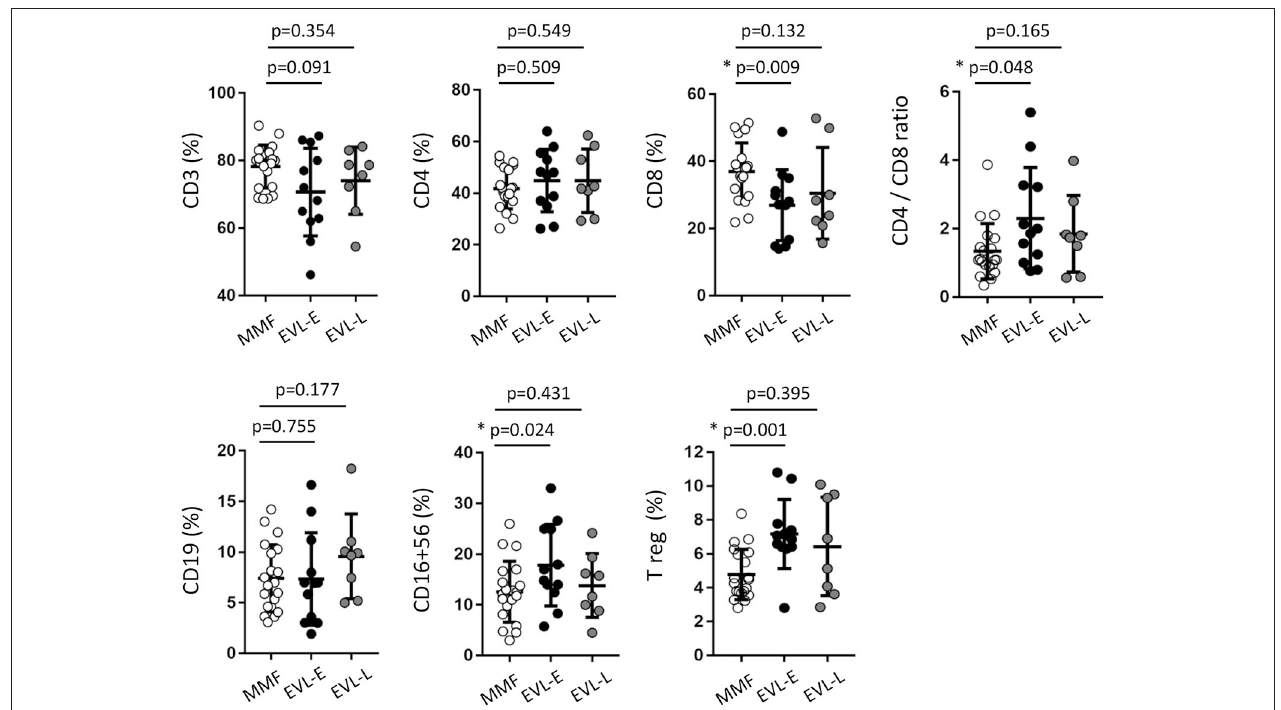
FIGURE 2 | Immune phenotype in peripheral blood of HT patients, by treatment group. The percentage of the immune cell subsets was determined in 50 µ l of peripheral blood obtained from HT patients at > 1 year post-transplant who were receiving therapy with MMF (MMF group, n = 20) or who were converted to EVL early (EVL-E, n = 12) or late (EVL-L, n = 8). Each circle represents one HT patient, and the mean and standard deviation are depicted as black bars. Significant differences between groups were determined by the Mann–Whitney U -test. * p <